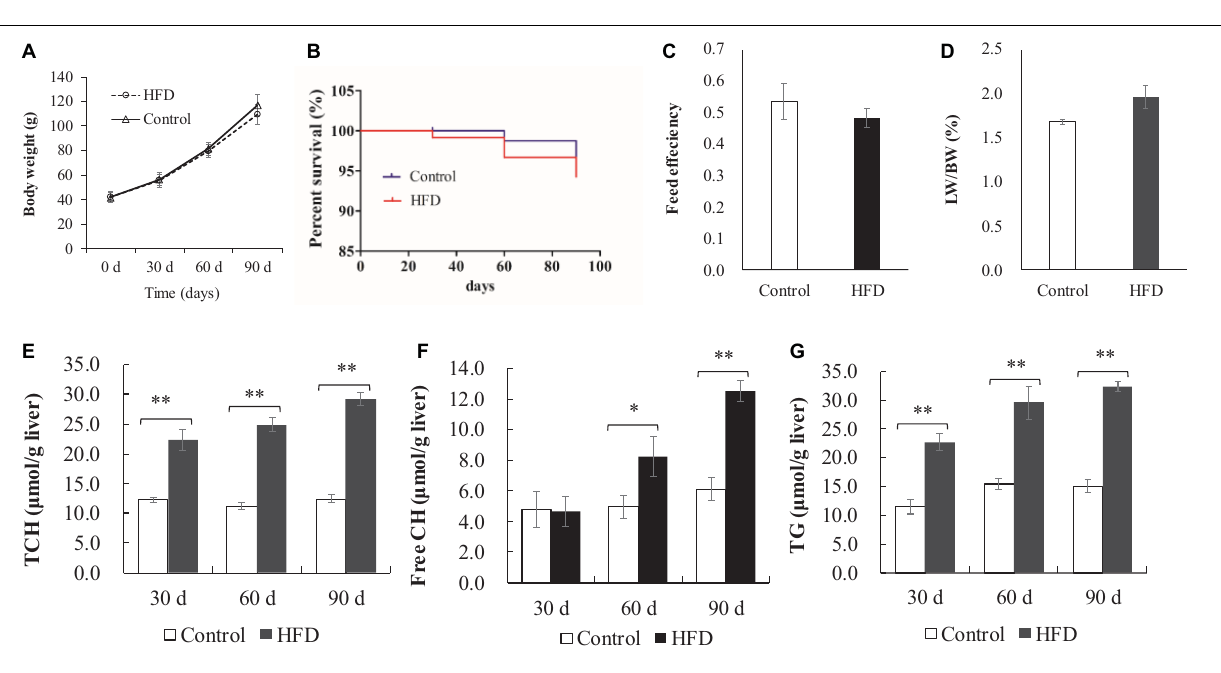
control group, HFD feeding caused a marked downregulation of tfeb, and its target genes including UV radiation resistance associated gene ( uvrag ) and mucolipin-1( mcoln-1 ) after 90